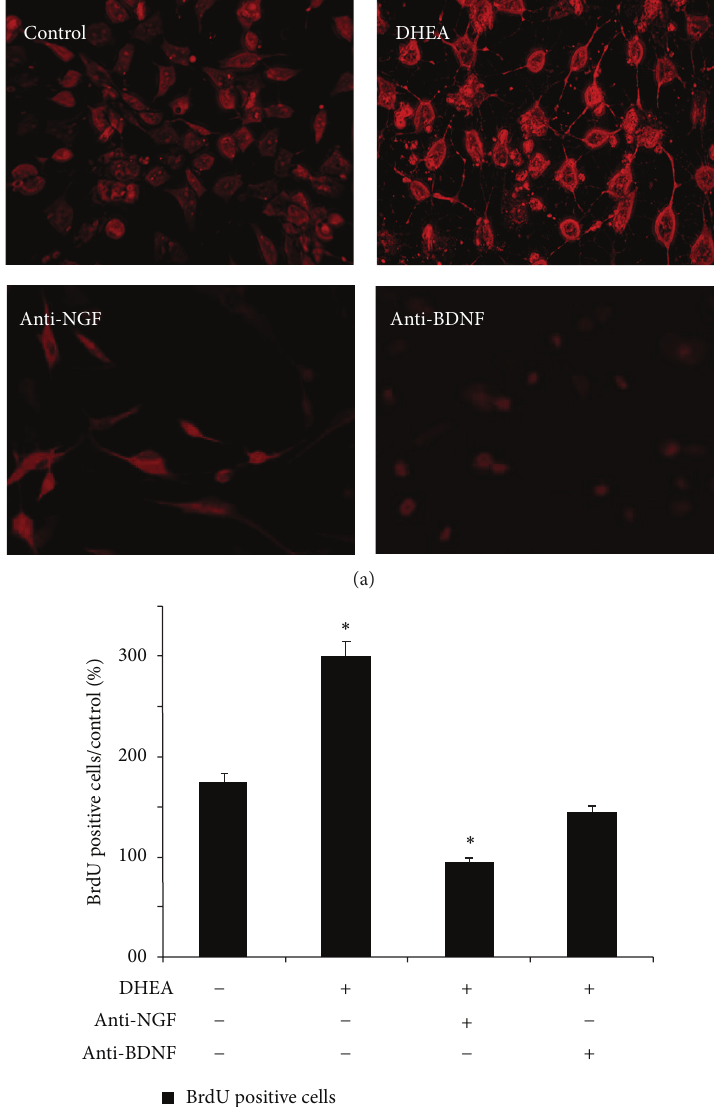
Figure 2: Number of BrdU+ cells. Representative image showing BrdU+ cells in the brain cortex under DHEA treatment and using antineurotrophins after DHEA treatment (a). The majority of BrdU+ cells which survive in brain cortex of Wistar rats (b). In each experiment, the data were obtained from nine